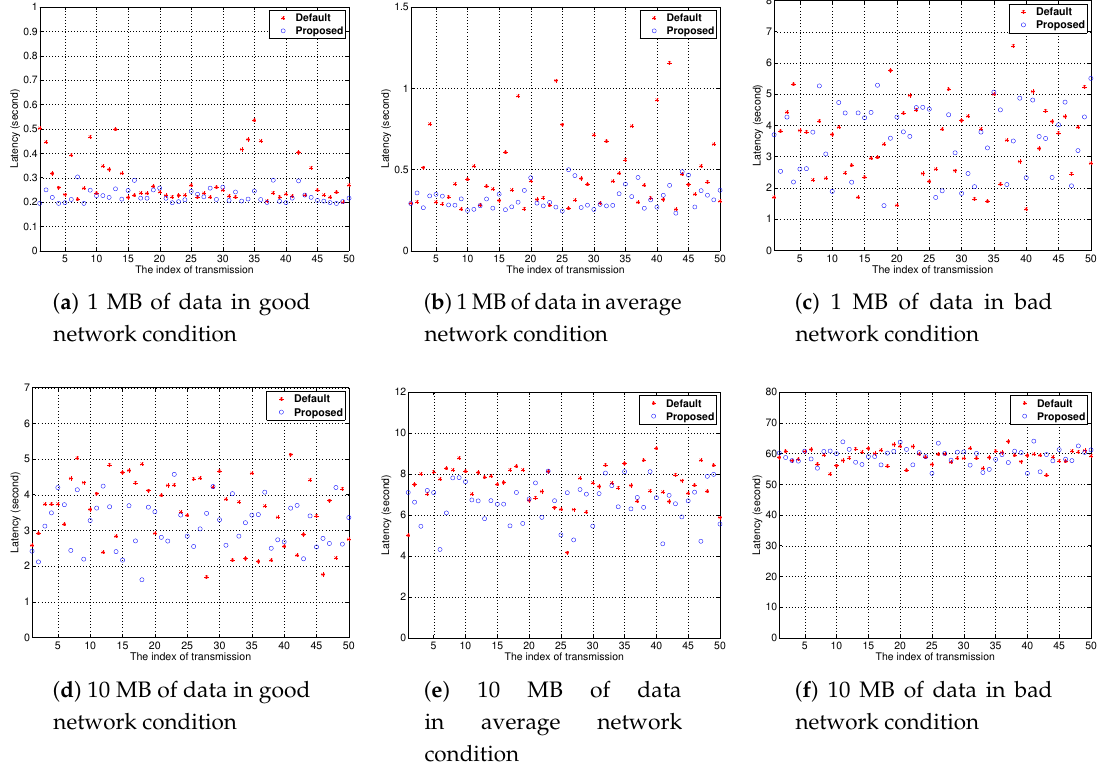
Figure 12. Transmission latency with dumbbell topology ( a – c ) 1 MB of data and ( d – f ) 10 MB of data in ( a , d ) good, ( b , e ) average and ( c , f ) bad network conditions.